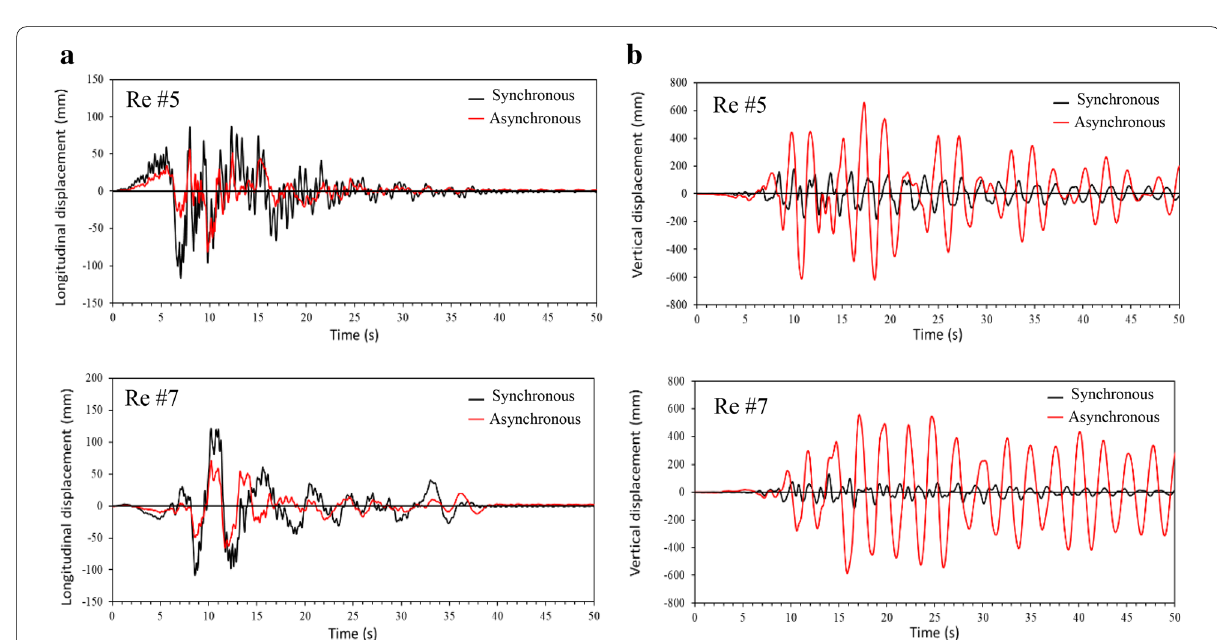
Fig. 7 Absolute displacement time histories for point B: a longitudinal displacement, b vertical